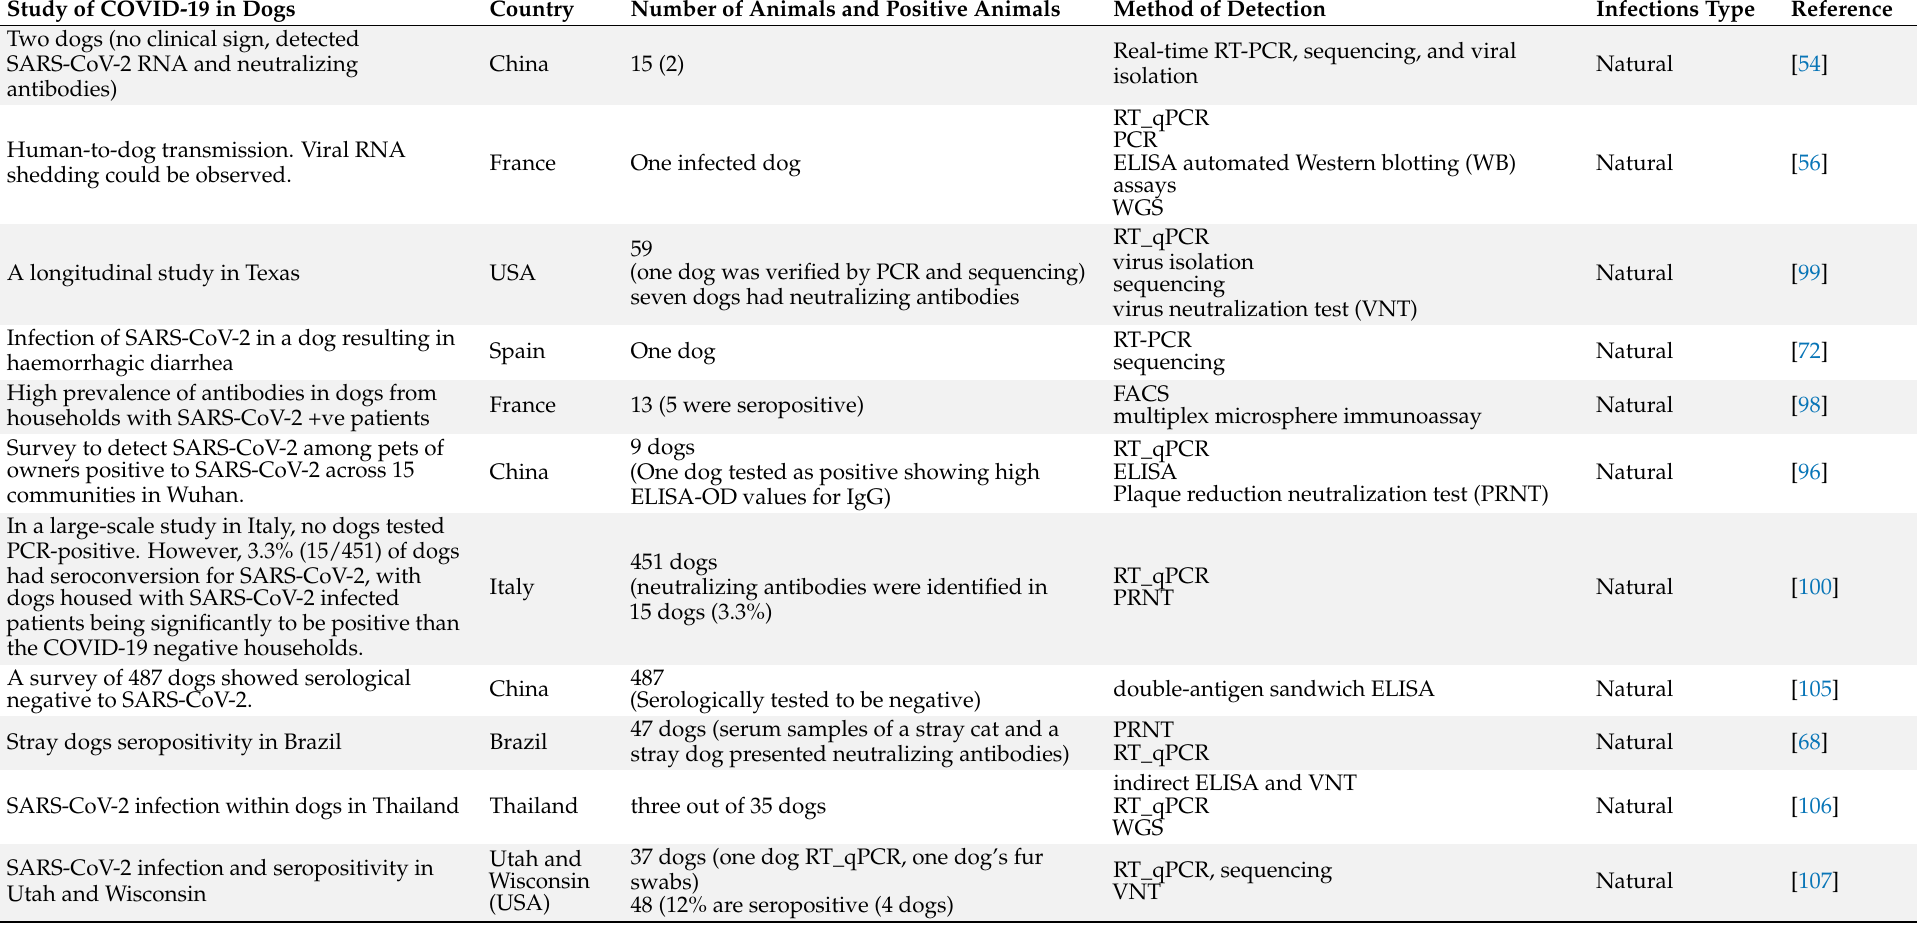
Table 1. Studies of COVID-19 in dogs and the country at which the study was